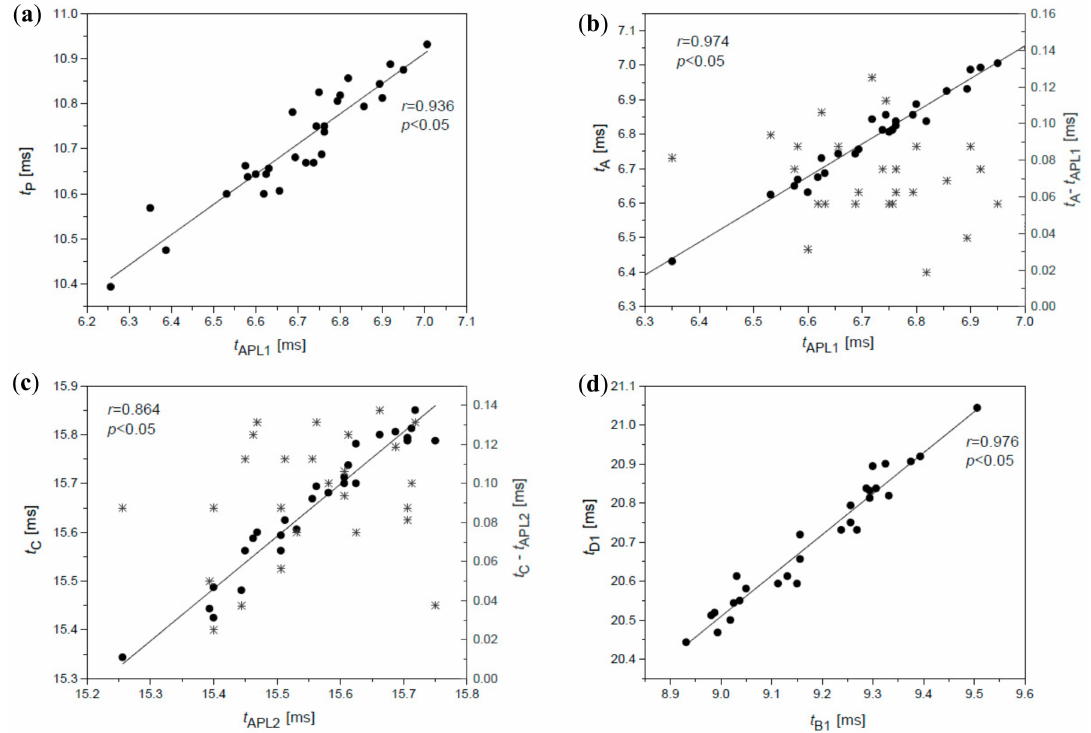
Figure 4. Dependence between the time of the first applanation t APL1 and the time of maximum pressure t P ( a ), the time of the first applanation t APL1 (dots) or the di ff erence between time t A and t APL1 (stars) and the time of first disruption t A and vs. ( b ), and the time of the second applanation t APL2 (dots) or the di ff erence between time t C and t APL2 (stars) and the time of the third disruption t C ( c ), time of disturbance t B1 , and time of disturbance t D1 ( d ) for participant no. 2.